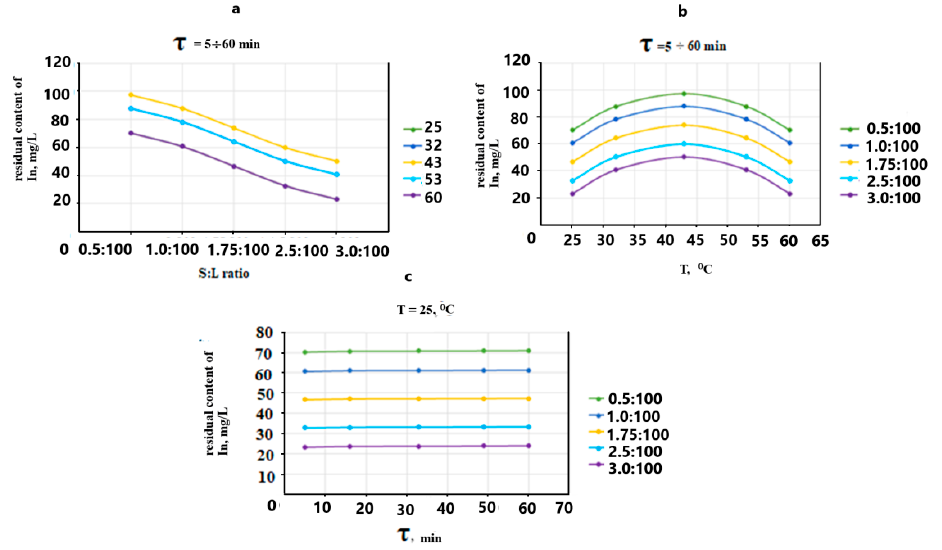
Figure 2. Influence of the studied factors on the residual content of In 3+ in the liquid phase of the “natural zeolite–In 3+ –Ga 3+ ” system. ( a ) zeolite norm (S:L); ( b ) temperature, °C; ( c ) time, min. The second significant factor affecting the sorption of the In 3+ cations is temperature (X 2 ). In the regression Equation (2), the effect of temperature is represented by the negative quadratic term. The sorption curves of indium (III) in the entire studied time interval for all S:L ratios are extreme in nature, with a pronounced maximum in the region of 43 °C (Figure 2b). The residual content of the In 3+ cations increases with an increase in the tem- perature up to 43 °C, and decreases above this temperature; the degree of their sorption decreases and then increases. So, at S:L = 0.5:100 at 25 °C, the sorption degree is 30%, at 32 °C-11%, at 43 °C-0.05%, and at 60 °C-29.5%. The appearance of a maximum in the indium sorption curves may be due to the physical adsorption of a part of the In 3+ cations, and may also be a consequence of the competing effect between the cations for the vacant ex- change centers in the zeolite structure, or the tendency of the system to equilibrium. The sorption curves of the indium (III) cations, from time to time, have a rectilinear character and are located parallel to the abscissa axis (Figure 2 с ). The time factor does not affect the process of sorption of the In 3+ cations by natural zeolite. Thus, a high degree of their sorption is already achieved in 5 min and remains almost constant. The least of the In 3+ cations in the presence of the Ga 3+ ions, regardless of time, is sorbed in the range of 40–45 °C at the S:L ratio = 0.5:100 (Ks = 0.8%), and the most of all is sorbed at 25 and 60 °C, at S:L = 3:100 (Ks = 71%). As for the sorption of the Ga 3+ cations in the presence of the In 3+ ions, the process is described by the Equation (9): Y Ga = 72.649 − 9.218X 22 − 12.709X 32 (9) The adequacy of the resulting regression equation is confirmed by the inequality F < F1-p(f 1 ,f 2 ) = Y Ga 4.642 < 4.699. From the resulting regression Equation (9) it can be seen that, as in the case of the indium (III) sorption, three coefficients b 0 , b 22 and b 32 (T, °C and time) have turned out to be significant. The comparison of the coefficient values of the regression Equation (9) has shown that the process time has the greatest influence on the output parameter, but the negative sign at the X 3 coefficient shows that an increase or decrease in the value of this factor will